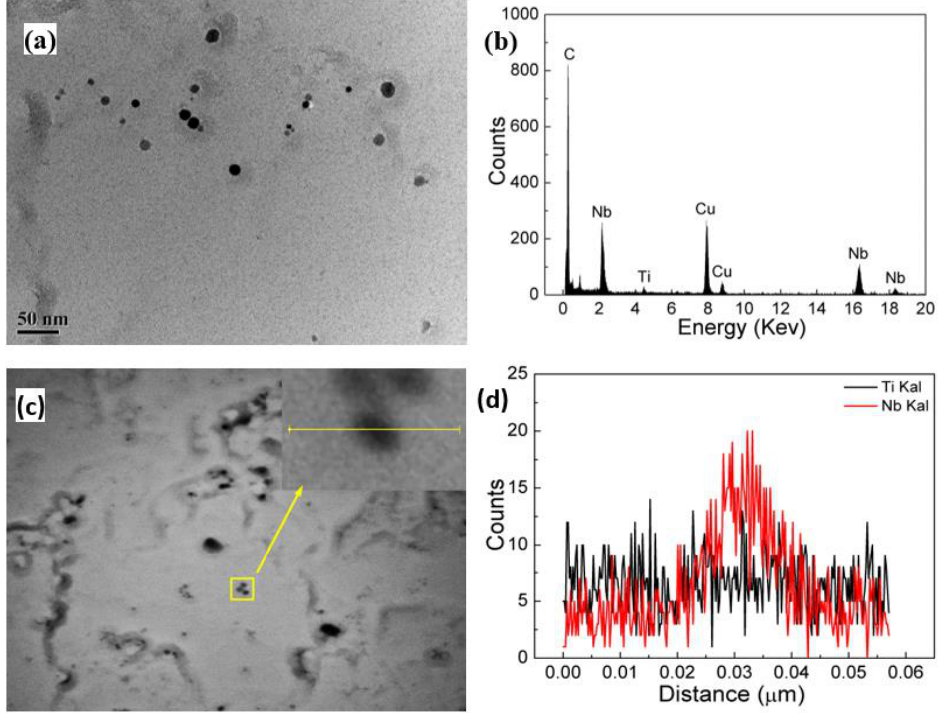
Figure 13. Precipitation morphology and chemical composition of experiment steel at peak temper- ature of 950 °C under the heat input of 10 kJ/cm: ( a ) precipitation morphology; ( b ) point scanning result; ( c ) line scanning location; ( d ) line scanning result.